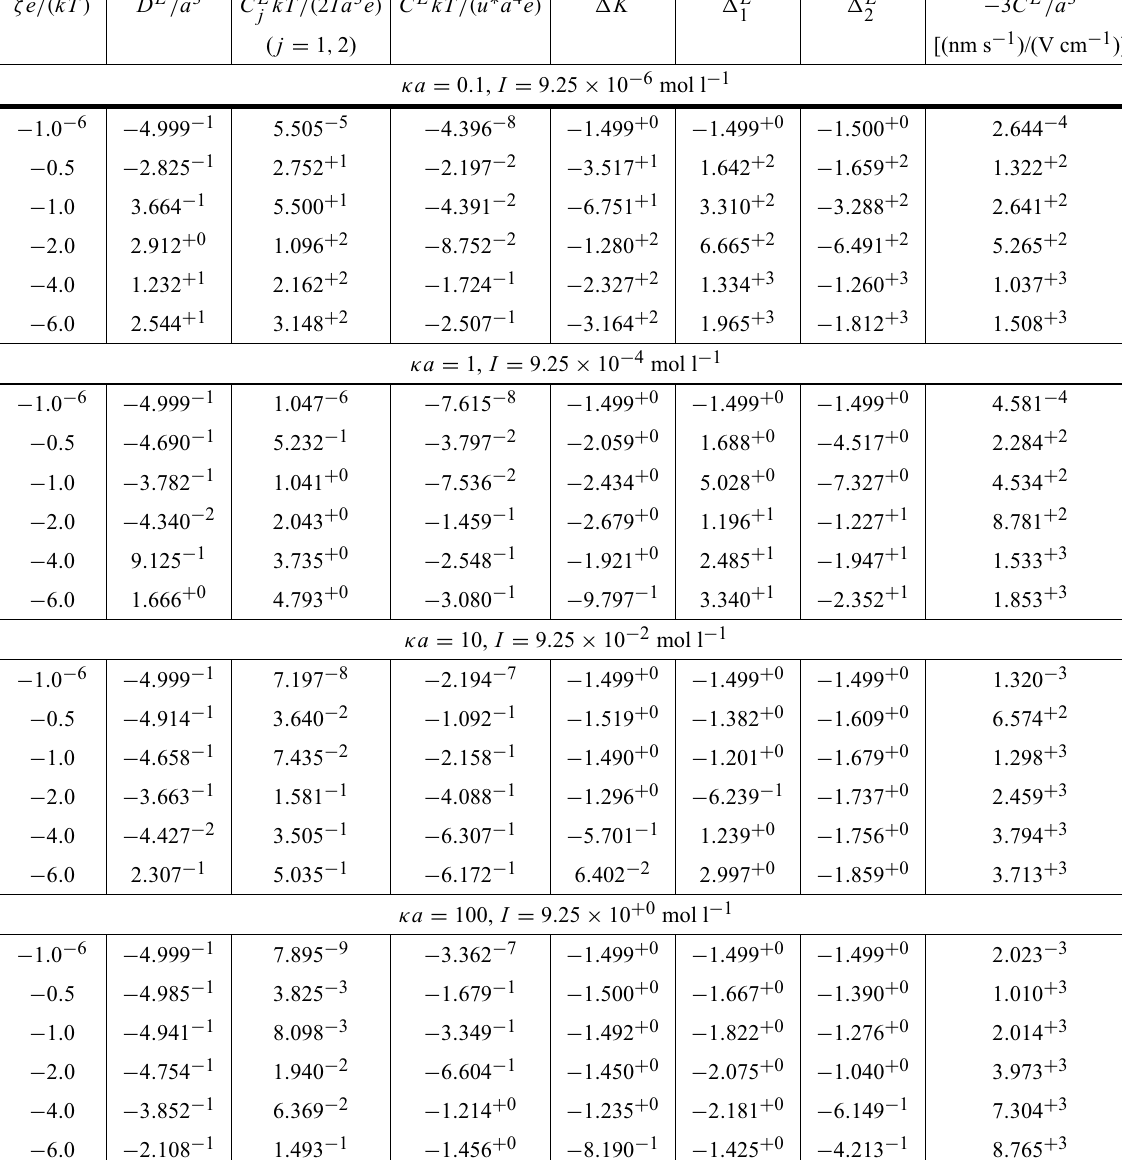
Scaled (dimensionless) asymptotic coefficients for bulk electromigration of NaCl in a Brinkman medium with charged spherical inclusions (see Hill 2006c, for details):